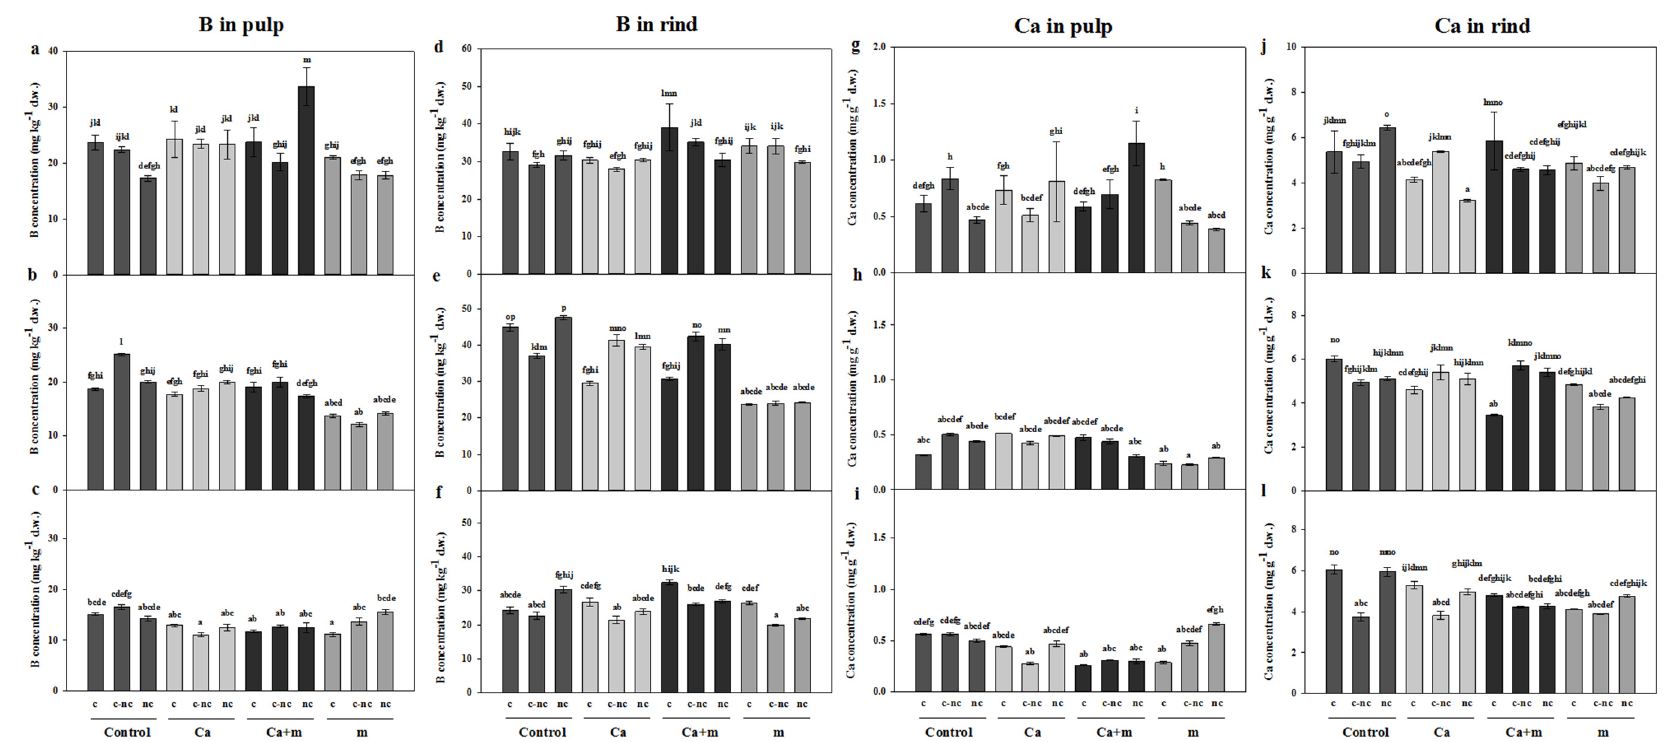
Figure 4. B concentration (dry weight basis) in pulp, ( a ) control irrigation, ( b ) conductivity irrigation, and ( c ) double irrigation, and rind, ( d ) control irrigation, ( e ) conductivity irrigation, and ( f ) double irrigation. Ca concentration (dry weight basis) in pulp, ( g ) control irrigation, ( h ) conductivity irrigation, and ( i ) double irrigation, and rind, ( j ) control irrigation, ( k ) conductivity irrigation, and ( l ) double irrigation. The Ca treatment consisted of 8 mM CaCl 2 and 2 mM CaSO 4 , the Ca + m treatment consisted of a commercial mixture (Antisal gold, Nufol ® ) and the m treatment consisted of another commercial mixture (Microfold, Nufol ® ). Codes: c, cracked region in cracked fruit, c-nc, non-cracked region in cracked fruit, nc, non-cracked fruit. Statistical analysis was performed using SPSS 25.0.0.1. and included all the irrigation treatments, separating each element and each type of tissue. The values are the means ± SE of three individual analyses. Columns with di ff erent letters di ff er significantly according to Duncan’s test ( p = 0.05).